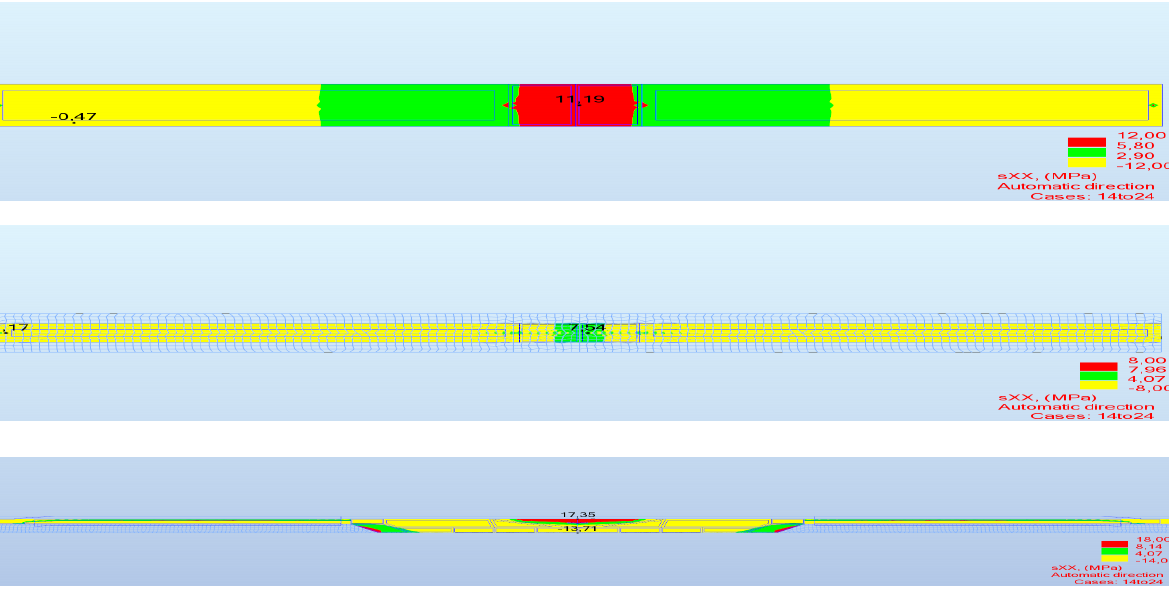
Figure 17: Tensile stress layout in in situ slab (top view), upper slab (top view) and concrete web of the prefab (side view) – cracked analysis (step